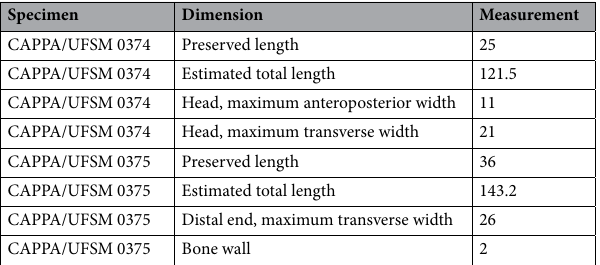
Table 1. Measurements (in mm) of the femur of Amanasaurus nesbitti gen. et sp.